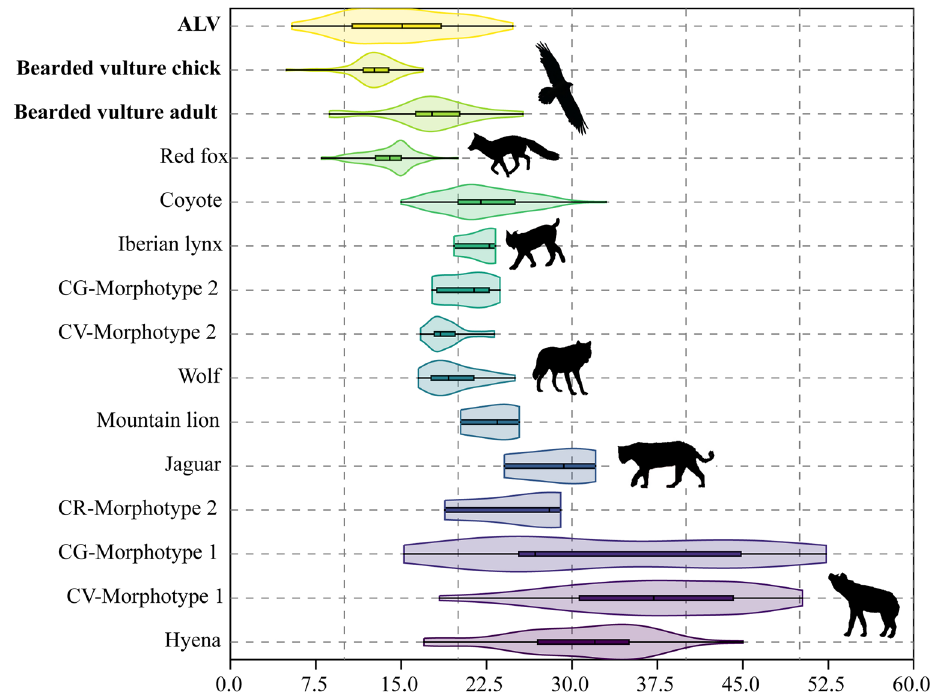
Figure 6. Violin plot of the diameter of bearded vulture scats and ALV coprolites (present study) compared to modern-day scats and coprolites according to morphotype (in mm) 22,23,30–32 . Morphotypes 1 and 2 refer to hyenid and non-hyenid carnivores, respectively. CG: Cova del Gegant. CV: Cova del Coll Verdaguer. CR: Cova del Rinoceront.